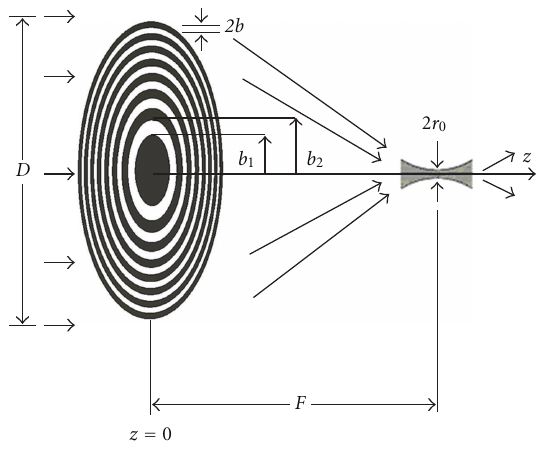
Figure 1: Plane-wave illuminated binary negative Fresnel zone plate